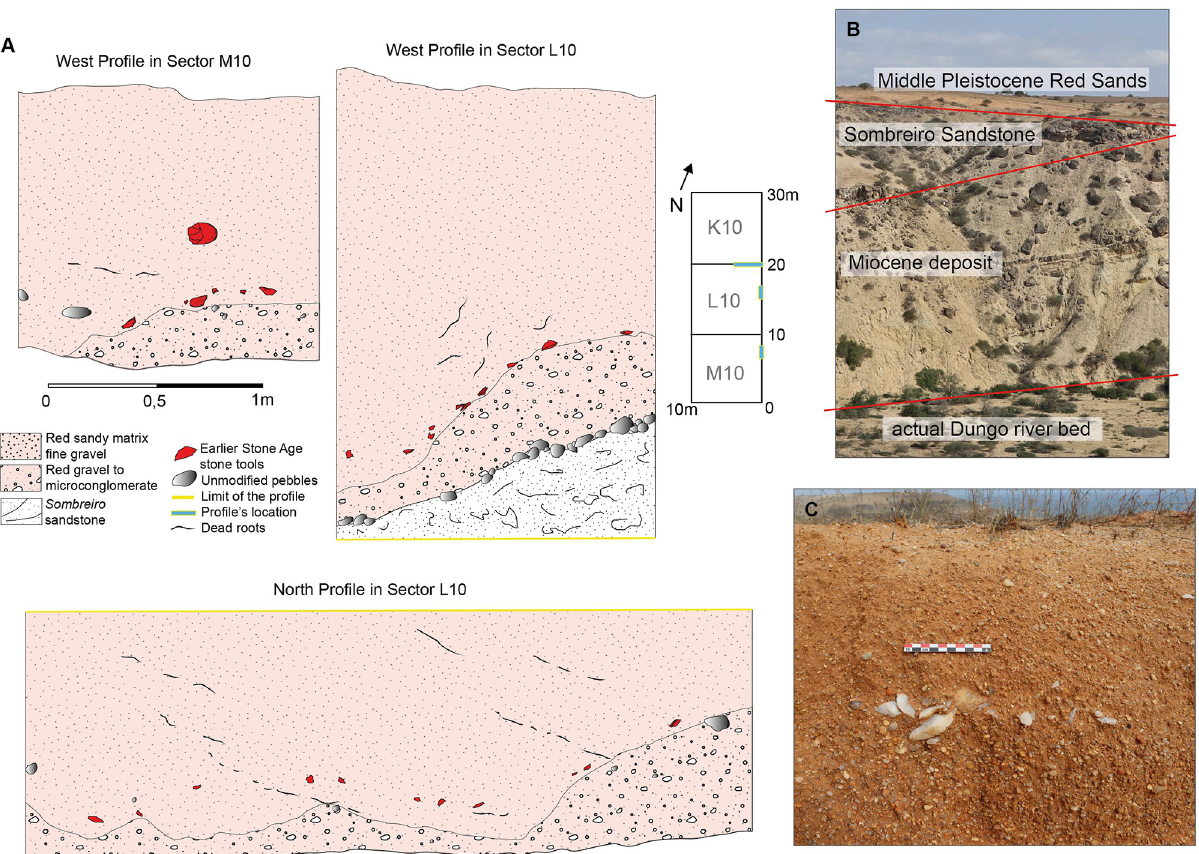
Fig 4. A: View of the +100 m terrace from the estuary of the Dungo river. B: Dungo IV’s sampling locations, stratigraphic log and modeled burial durations [modified from 149].